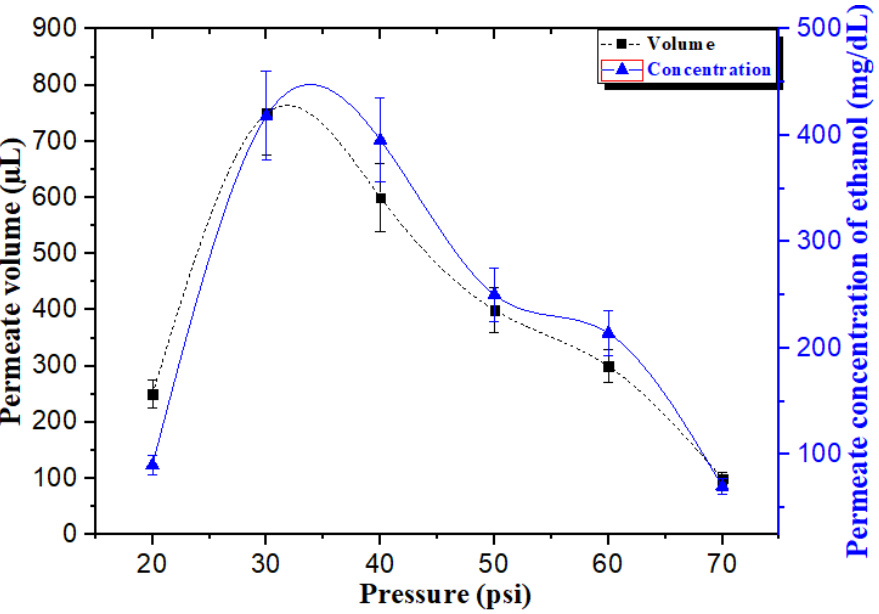
Figure 11. Pervaporation process of 25% ethanol to water using poly (MMA- co -MA) membrane under different nitrogen pressures.